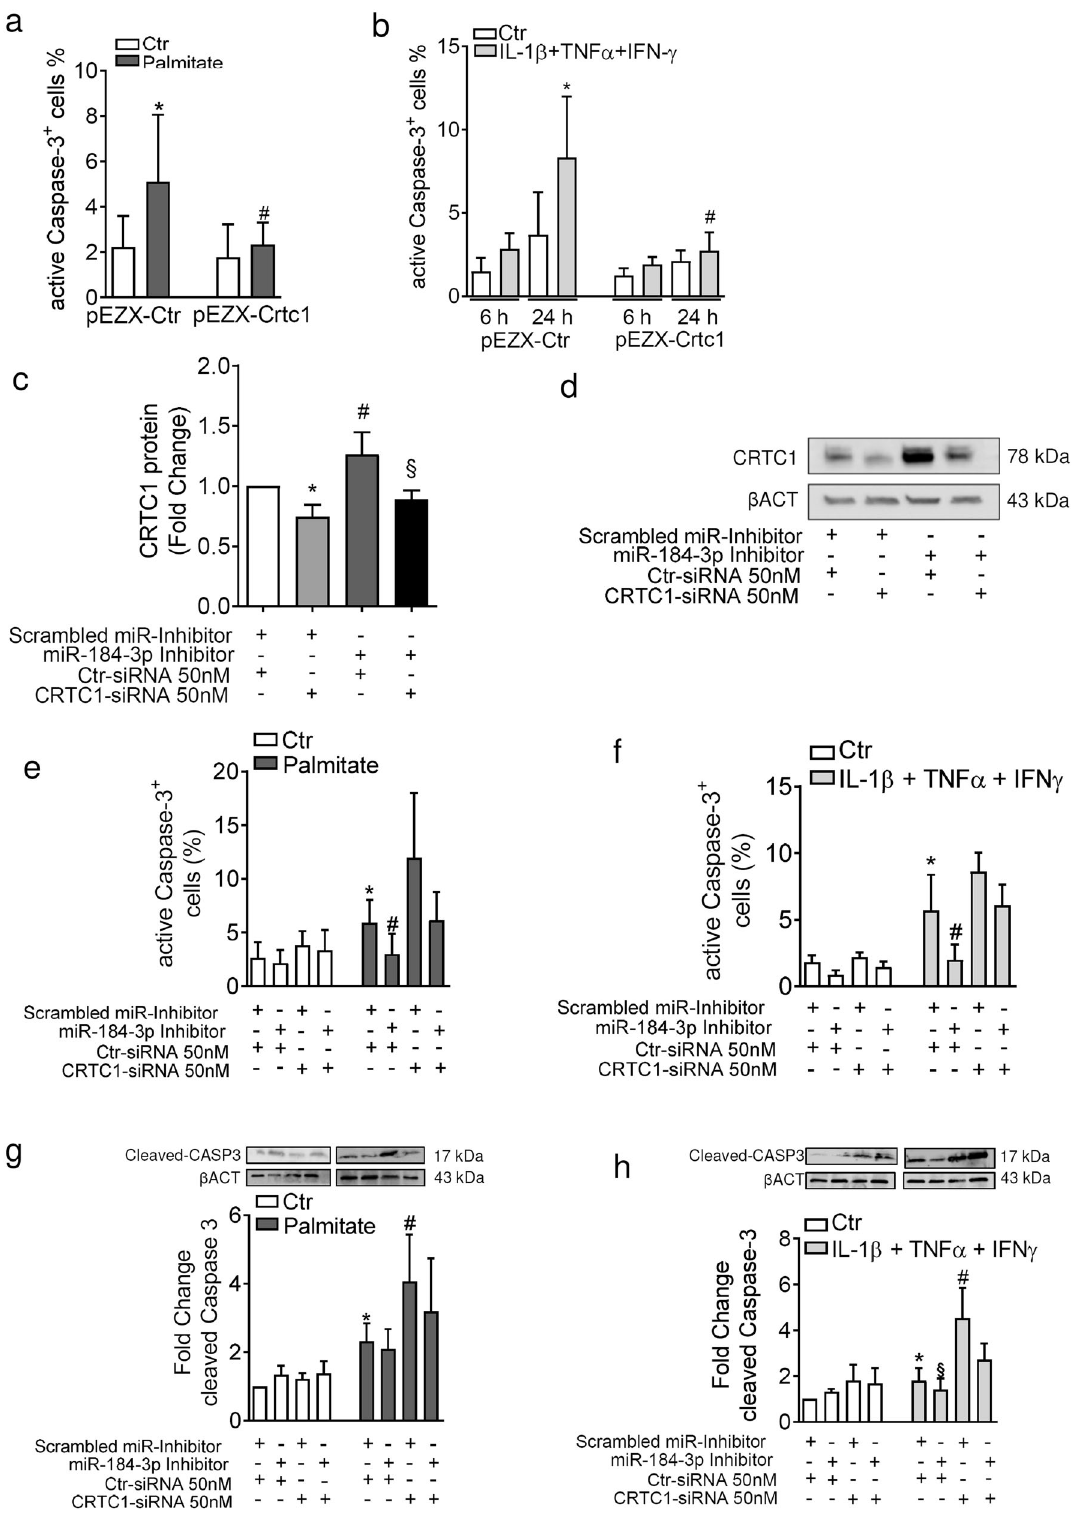
factor NKX6.1, while only a single binding site was detected in the murine miR-184-3p promoter sequence (Fig. 5a, left and right panels, and Supplementary File 2). NKX6.1 DNA-responsive elements (DRE) were characterised by the typical homeodomain core sequence binding motif belonging to NKX6.1